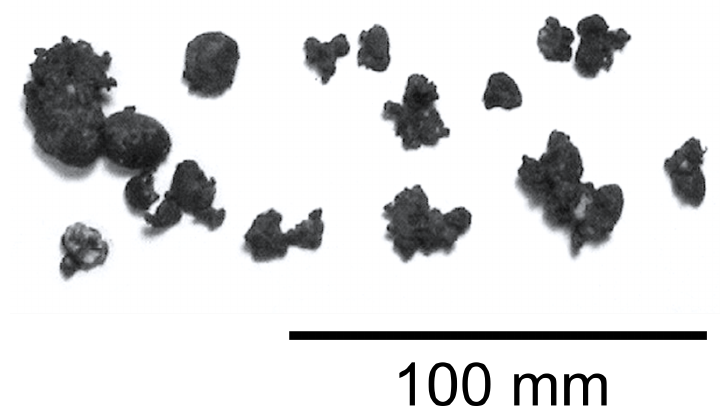
Figure 2. Example of a typical Argon Oxygen Decarburization (AOD) slag sample taken at the end of the decarburization period.